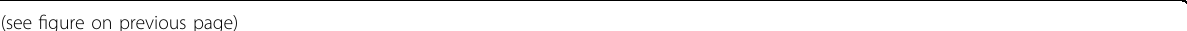
Fig. 3 High glucose (HG) accelerates stress-induced premature senescence in endothelial progenitor cells (EPCs). a EPCs from healthy subjects incubated with increasing concentrations of glucose (15 and 30 mM) for 24 – 72 h. Cell viability was measured by the MTT assay. The percentage of viable cells was analyzed, and data are presented as the mean ± SD ( n = 3). * P < 0.05, ** P < 0.01 vs. normal glucose (NG, 5.5 mM). b The intracellular ROS level of EPCs was determined by immuno fl uorescence using DCH-DA stain after exposure to HG (30 mM) for different lengths of time. Representative immuno fl uorescence images of ROS formation (red fl uorescence) and DAPI (blue fl uorescence) in EPCs. (Magni fi cation ×200). Scale bar, 40 μ m. c The average fl uorescence intensity of DHE in each group. n = 5, ** P < 0.01, *** P < 0.001 vs. NG. d – i Western blot analysis shows the protein expression levels of SMP30, VEGF, VEGFR2, and NOX1/4. GAPDH served as an internal control. The relative protein levels were analyzed, and data are presented as the mean ± SD ( n = 3). * P < 0.05, ** P < 0.01, *** P < 0.001 vs. NG group. j Apoptosis was determined by Annexin-V/PI staining after induction with 30 mM HG for 24 – 72 h. Percentage of apoptotic cells was measured, and data are presented as the mean ± SD ( n = 3). *** P < 0.001 vs. NG glucose. k – m In fl ammatory cytokine levels of IL-1 β , IL-6, and TNF- α were measured by ELISA. The relative protein levels were analyzed, and data are presented as the mean ± SD ( n = 3). *** P < 0.001 vs. NG